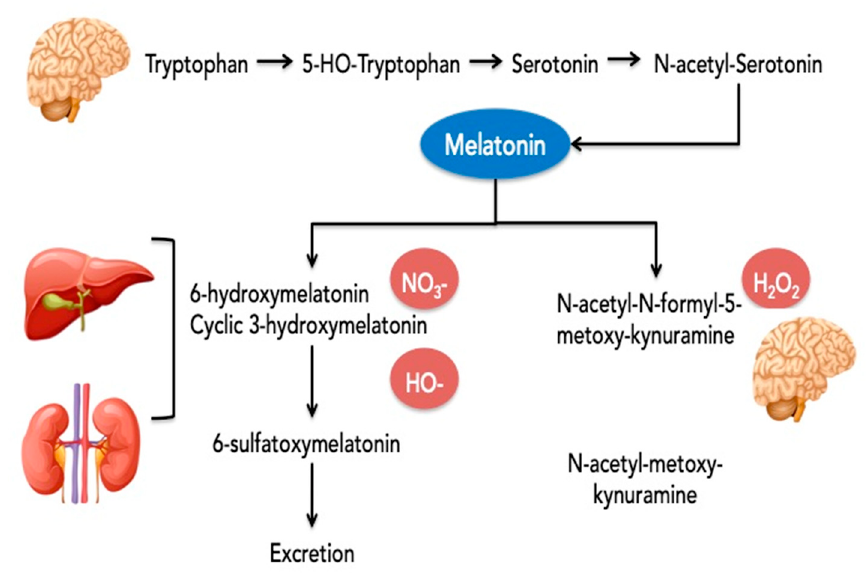
Figure 2. Metabolism of melatonin and the predominant targets of the different metabolites for the antioxidative effect.